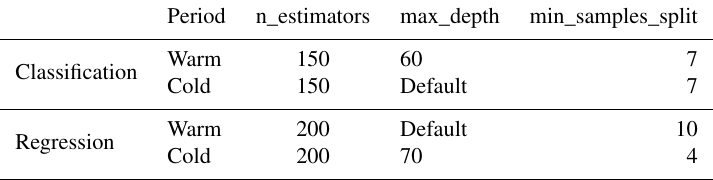
Table C1. The optimal parameters of RF model training.